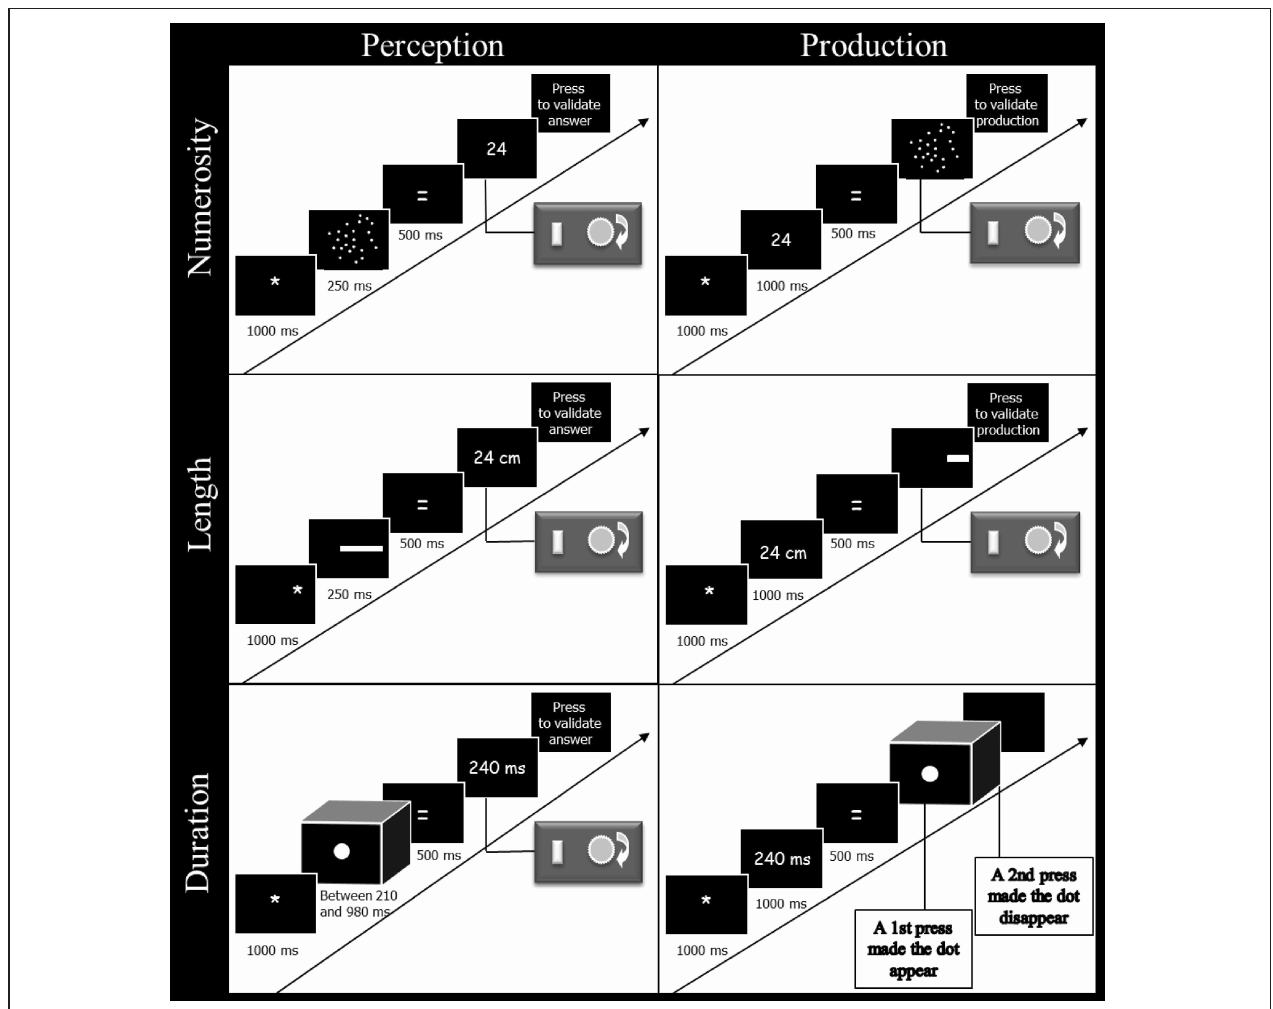
been displayed. In the production tasks, they had to produce a stimulus with a numerosity, length, or duration corresponding to the given value, by using the potentiometer after the sign “ = ” had been displayed. Responses were validated by pressing a button on the response box.